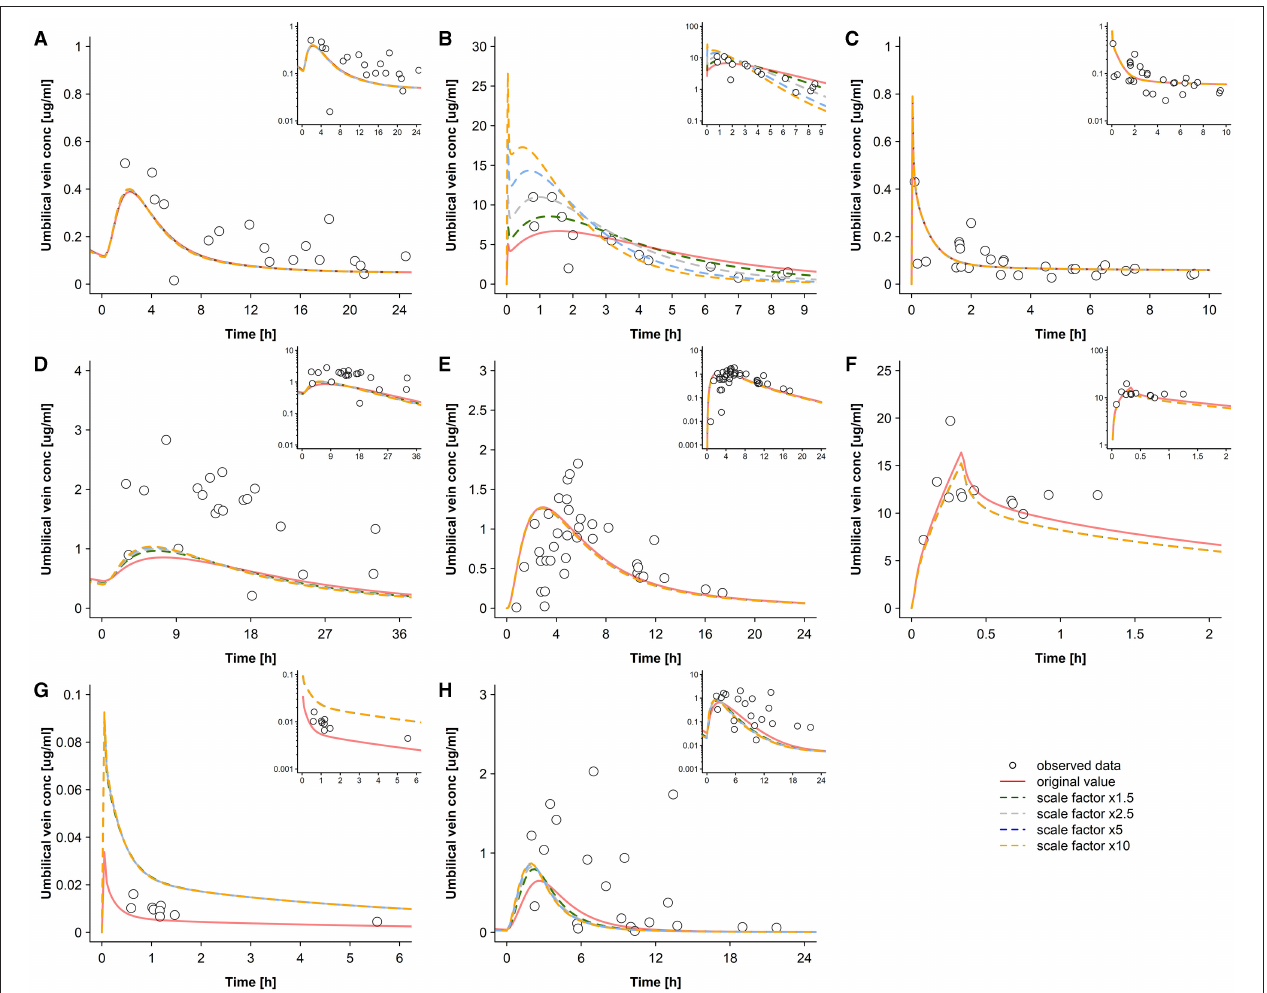
FIGURE 8 | Sensitivity analysis for the transfer clearance across the basolateral trophoblast membrane. Concentration-time profiles in the umbilical vein plasma for acyclovir (A) , cefuroxime (B) , diazepam (C) , dolutegravir (D) , emtricitabine (E) , metronidazole (F) , ondansetron (G) , and raltegravir (H) at delivery in the third trimester. Semi-log scaled figures are shown as inset plot in the top-right corner of each panel. The time refers to the time after drug administration. Circles represent individual observed data and the lines represents the predicted geomean concentrations with different transfer clearances across the basolateral trophoblast membrane (both influx and efflux transfer clearance are equally altered). Observed data for acyclovir, cefuroxime, diazepam, dolutegravir, emtricitabine, metronidazole, ondansetron, and raltegravir were taken from Liu et al. ( 18), Leung et al. (39), Hirt et al. (40), Philipson and Stiernstedt (41), De Leeuw et al. (42), Elkomy et al. (43), Visser and Hund (44), Moore and McBride (45), Ridd et al. (46), and Mandelli et al. (47), respectively. conc,